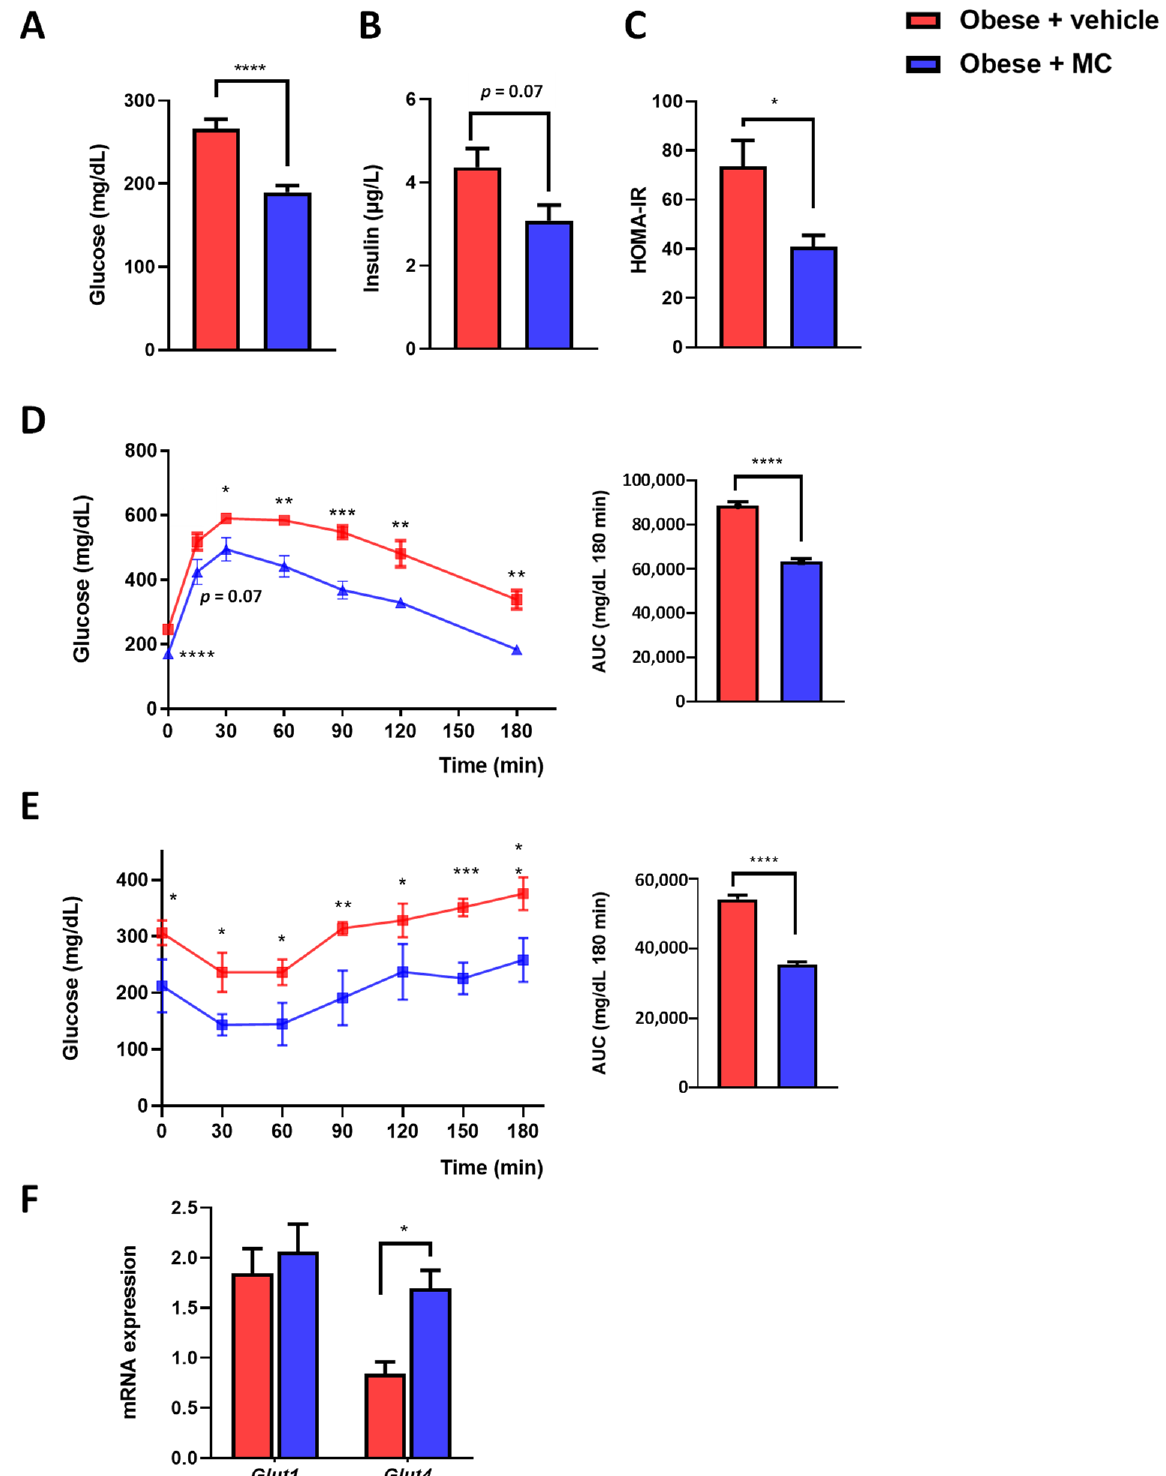
Figure 3. MC supplementation promotes improved glucose and insulin resistance by increasing the expression of Glut4 in EWAT. ( A ) Fasting glucose; ( B ) fasting insulin; ( C ) HOMA-IR; ( D ) glucose tolerance test (GTT) and area under the curve (AUC); ( E ) insulin tolerance test (ITT) and AUC; ( F ) EWAT mRNA expression of Glut1 and Glut4 . Data are mean ± SEM. * p < 0.05, ** p < 0.01, *** p < 0.001, **** p < 0.0001.